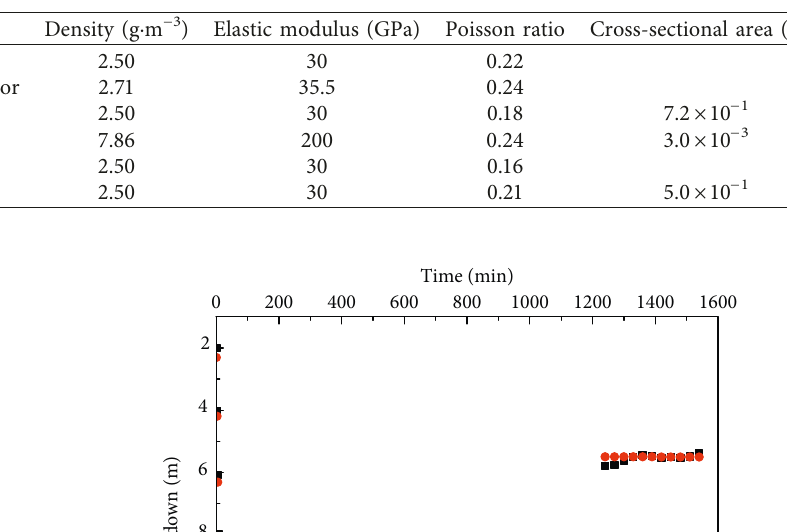
Table 5: Calculation parameters of structural